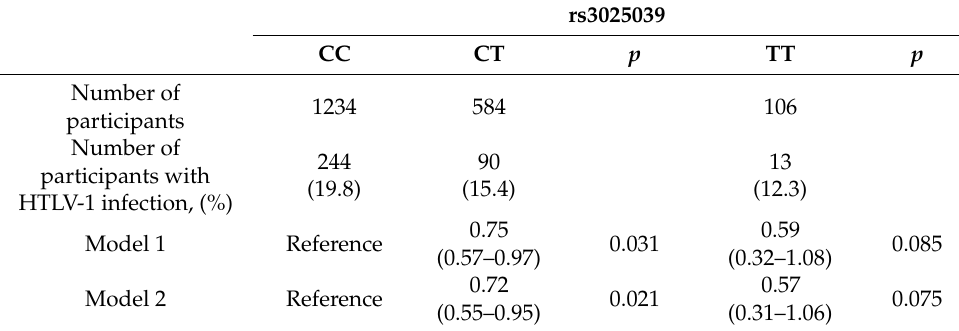
Table 2. Association between rs3025039 genotype and